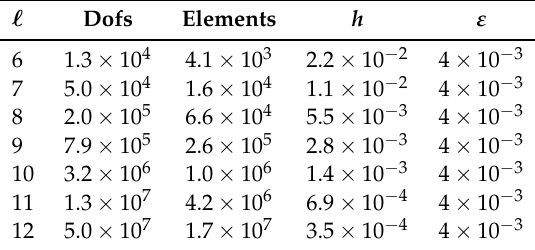
Table 3. Values and parameters for the different refinement levels of the single-edge notched shear/tension tests.